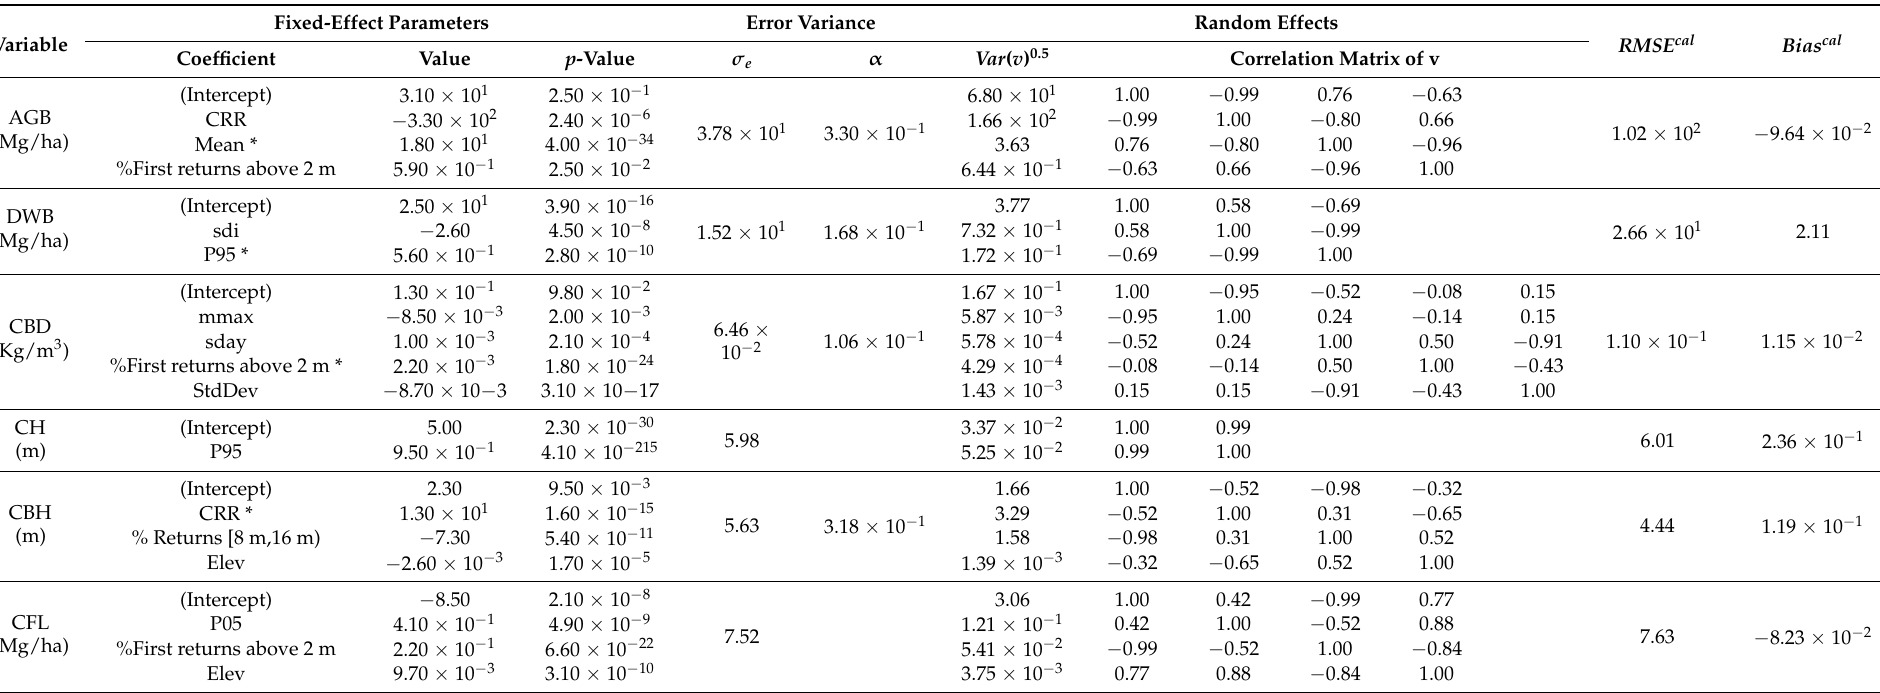
Table A5. Parameters and global performance metrics of linear mixed-effects models using rasterized ALS predictors. * Indicates the most correlated predictor used to model heteroscedasticity. Model response variables are: aboveground biomass (AGB), downed woody biomass (DWB), canopy bulk density (CBD), canopy height (CH), canopy base height (CBH), and canopy fuel loading